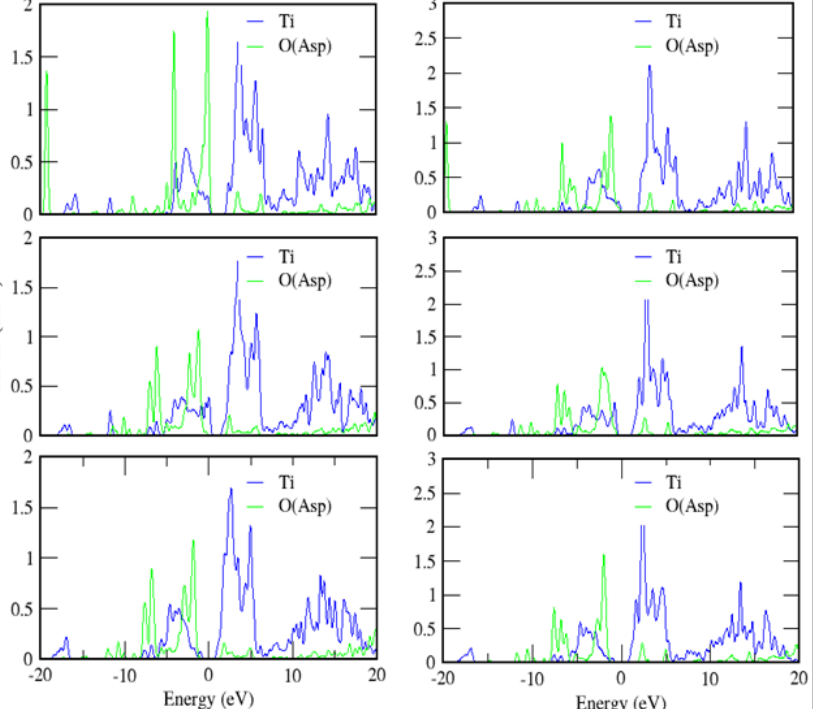
Fig. 8. PDOS for the adsorption of aspirin molecule on the N-doped nanoparticles, a: A complex, b: B complex, c: C complex, d: D complex, e: E complex and f: F complex.